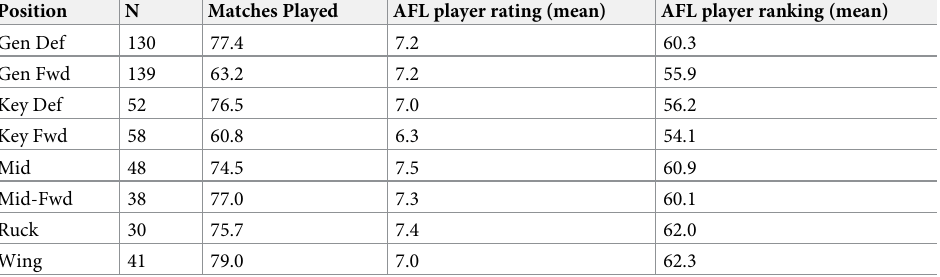
Table 2. Summary of